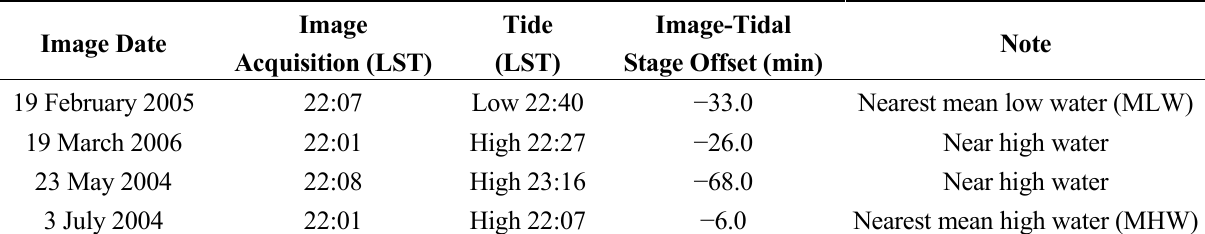
Table 1. Selected image acquisition times, flood/ebb peaks, and tidal offsets (Local Standard